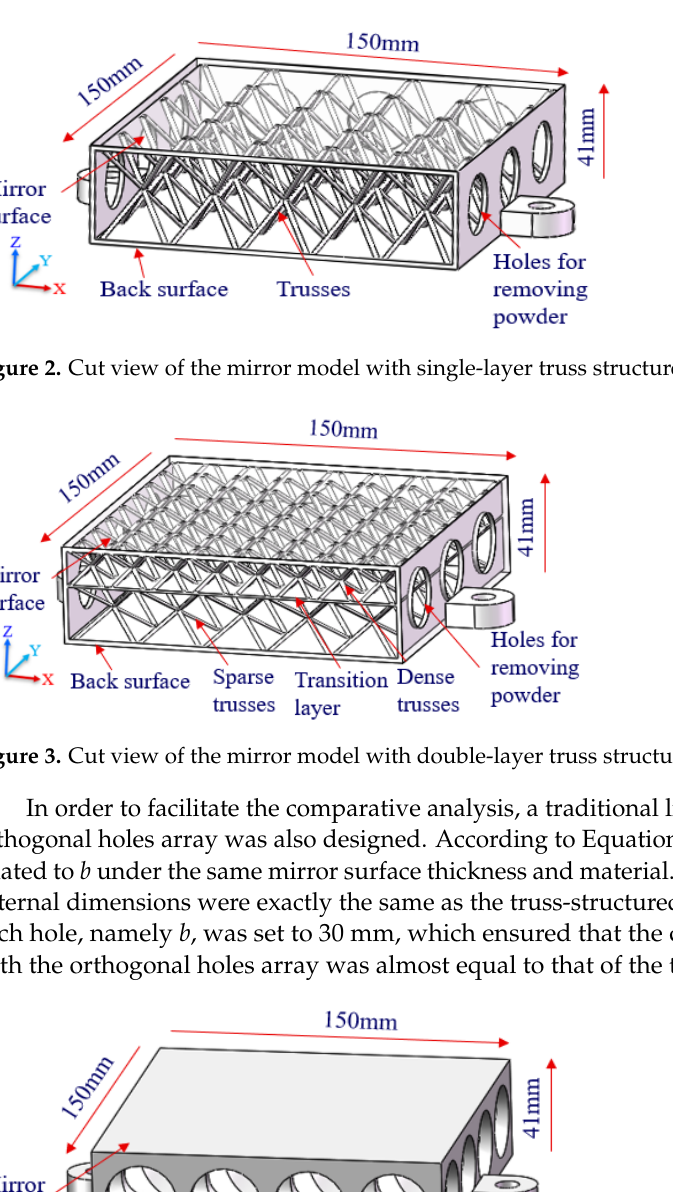
Figure 2. Cut view of the mirror model with single-layer truss structure.